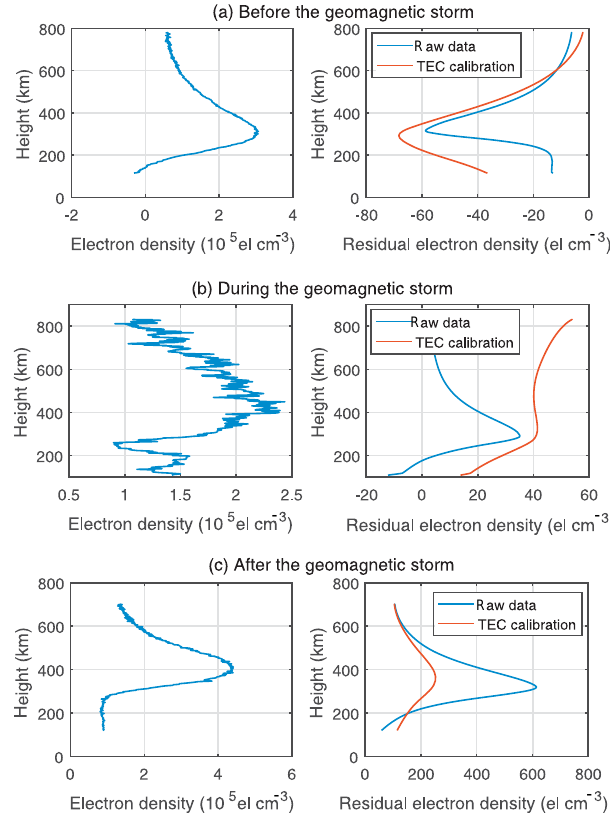
Figure 14. The profile of electron density (left panel) and its high- order ionospheric residual electron density (right panel) before the geomagnetic storm, during the geomagnetic storm and after the ge- omagnetic